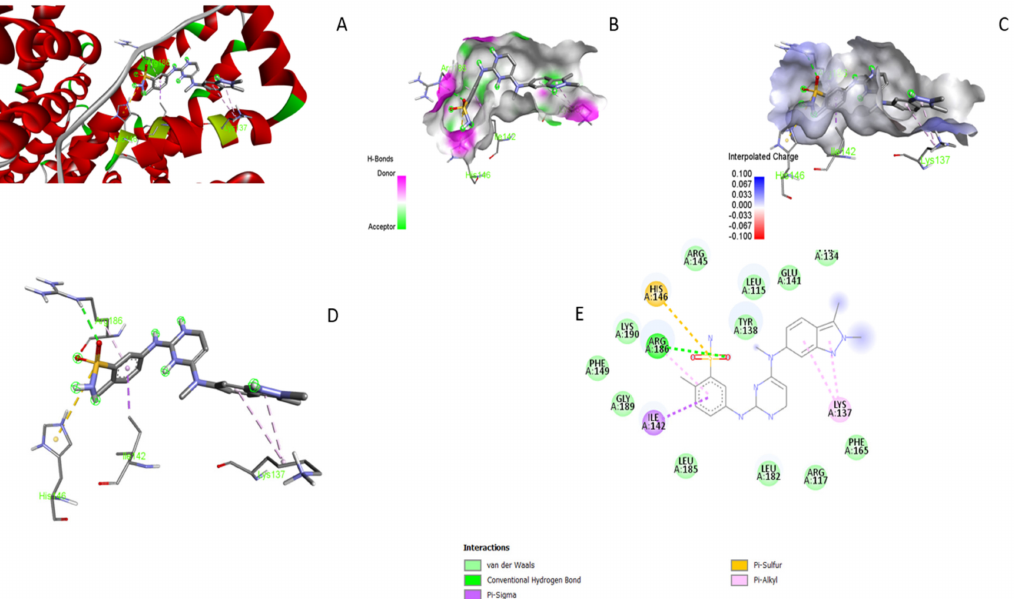
Figure 9. Three-dimensional representation of the interaction of PAZ with the receptor ( A , D ). Inter- actions in this region are strong, as PAZ acts as both an acceptor and donor for hydrogen bonding ( B ). Receptor-ligand interaction occurs in the neutral region ( C ). The most significant contributor to the docking score of PAZ is the pi-sulfur bond ( E ) that occurs in the neutral region. Although the pi bonds are weak interactions, the pi-sulfur interaction here is quite strong since it occurs with the double bond of PAZ.